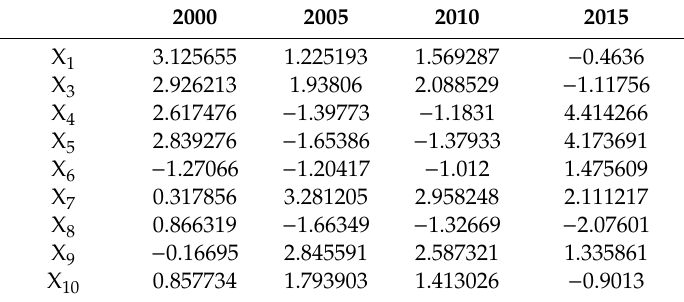
Table 3. Principal Component Analysis (PCA) weighted